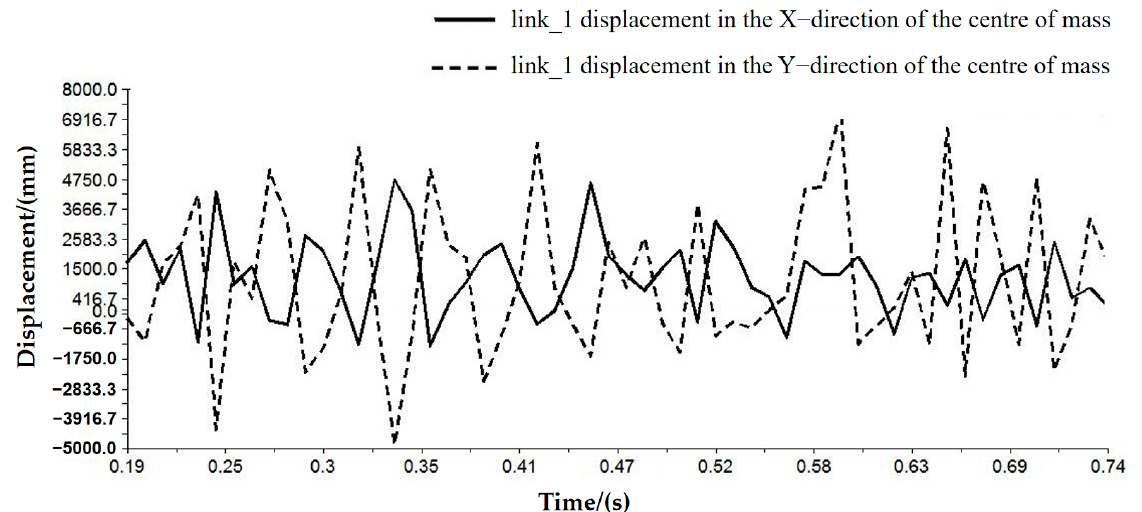
Figure 13. Acceleration of link_1. Figures 14 and 15 show the variation of the link_1 mass in the y-direction (vertical axis) vs. the displacement of the link_1 mass in the x-direction (horizontal axis).